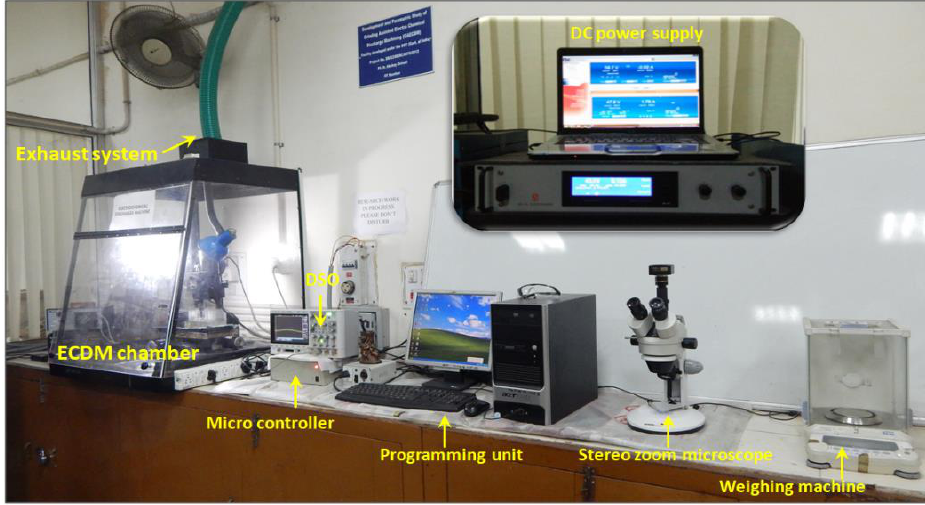
Figure 1. Pictorial view of ECSM machine.